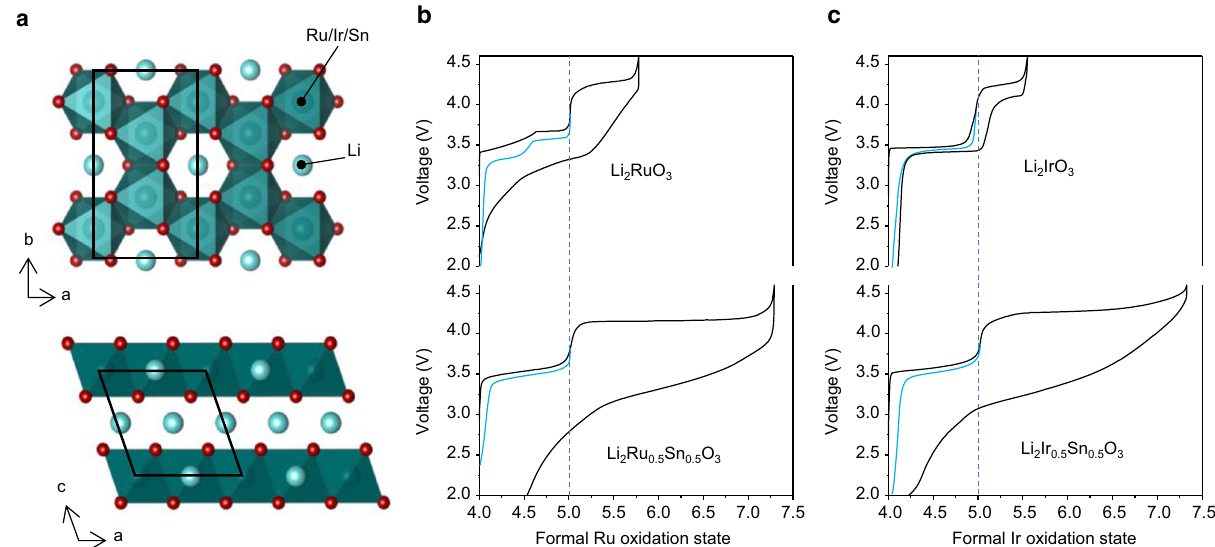
Fig. 1 Structure and electrochemistry of Li-rich 4d- and 5d-based cathodes. a O3-type layered structure with honeycomb ordering of Li and TM ions within the TM layers. First cycle load curves for b Li 2 RuO 3 and Li 2 Ru 0.5 Sn 0.5 O 3 and ( c ) Li 2 IrO 3 and Li 2 Ir 0.5 Sn 0.5 O 3 from 2.0 V to 4.6 V at a current rate of 20 mA g − 1 plotted against formal oxidation state of Ru or Ir (in black). Electrochemical cycling is reversible with little voltage hysteresis below + 5 (in blue). High voltage charging plateaus are observed in all materials beyond the + 5 TM oxidation state. The plateaus are accompanied by signi fi cant voltage loss on subsequent discharge in all cases except for Li 2 IrO 3